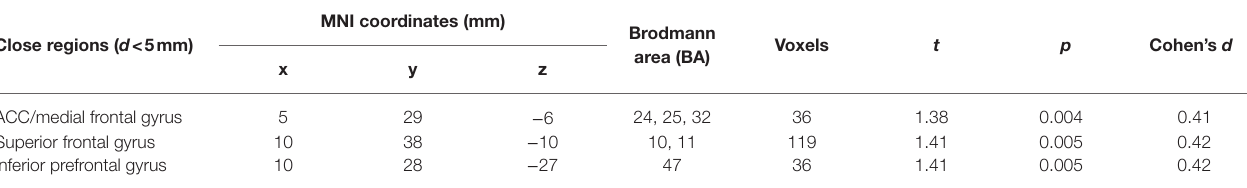
TABLE 5 | Summary of significant results provided by whole-brain sLORETA analyses for 130–210 ms (N170 component) after invalidly cued fearful probes with older versus younger participants.